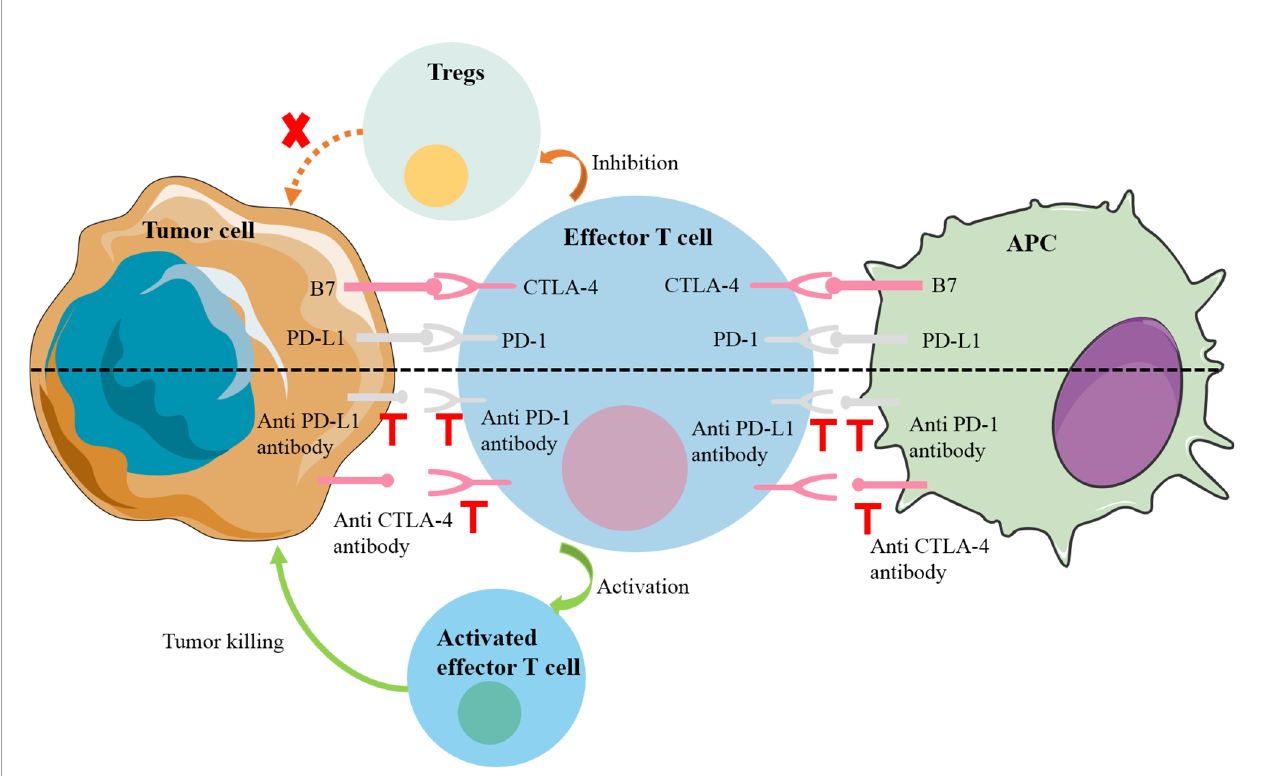
FIGURE 1 | Mechanisms of common immune checkpoint inhibitors. PD1 on the surface of effector T cells interacts with PD-L1 on the surface of tumor cells, downstream signaling pathways are induced to directly inhibit tumor cell apoptosis and stimulate the conversion of effector T cells to Tregs. In a similar manner, CTLA-4 on the surface of T cells can preferentially bind to the receptors (B7-1; B7-2) on the surface of APC to inhibit the activity and proliferation of T cells. APC, antigen-presenting cell; CTLA-4, cytotoxic T-lymphocyte-associated protein 4; PD-1, programmed cell death 1; PD-L1, PD-1 ligand; Treg, regulatory T